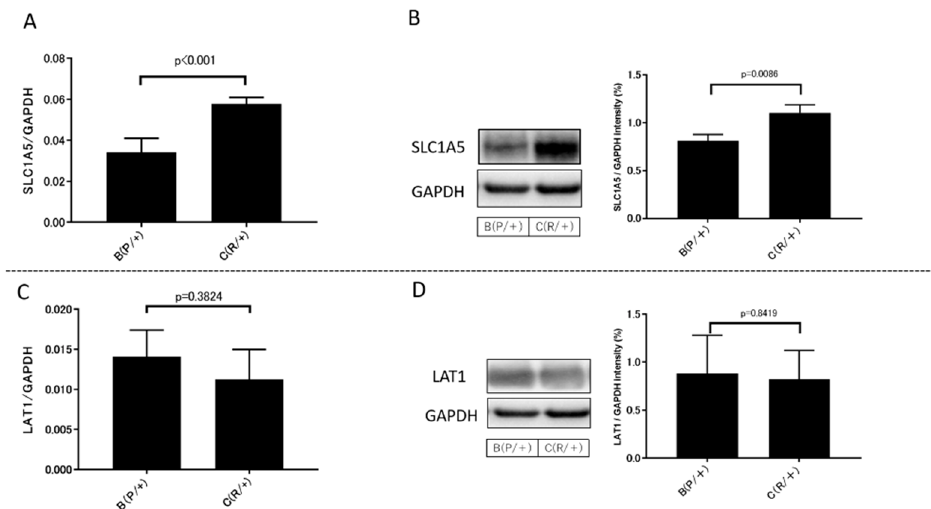
Figure 6. SLC1A5 is overexpressed in sunitinib-resistant cells: ( A ) qRT-PCR analysis demonstrated that SLC1A5 expression was significantly increased in group C (R/+) compared with that in group B (P/+) ( p < 0.001); ( B ) Western blot analysis indicated that SLC1A5 protein expression was significantly increased in group C (R/+) compared with that in group B (P/+) ( p = 0.0086); ( C ) LAT1 expression was not significantly different between the two groups ( p = 0.3824); ( D ) LAT1 protein expression was not significantly different between the two groups ( p = 0.8419).In qRT-PCR and western blot analysis, at least three independent experiments were performed. SLC1A5 and LAT1 expression levels were normalized to GAPDH expression in each sample. Data were analyzed for statistical significance by the Mann–Whitney U test.